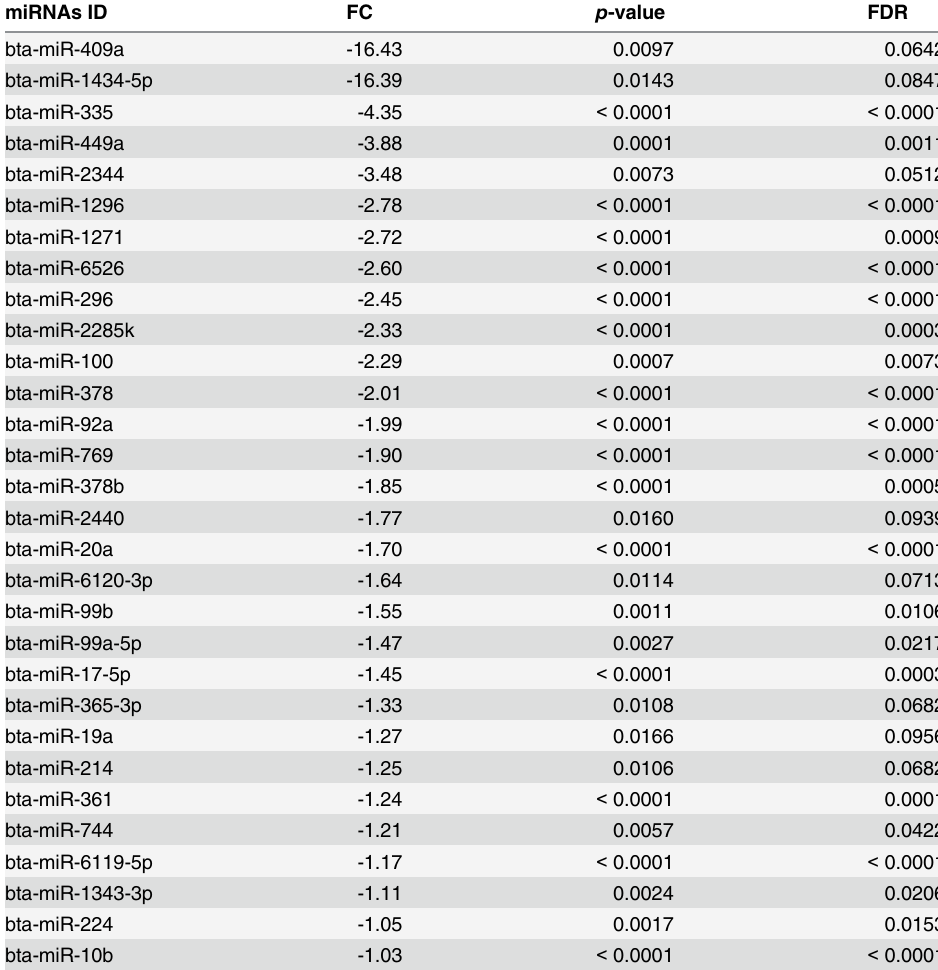
Table 5. List of miRNAs down-regulated in granulosa cells of preovulatory dominant